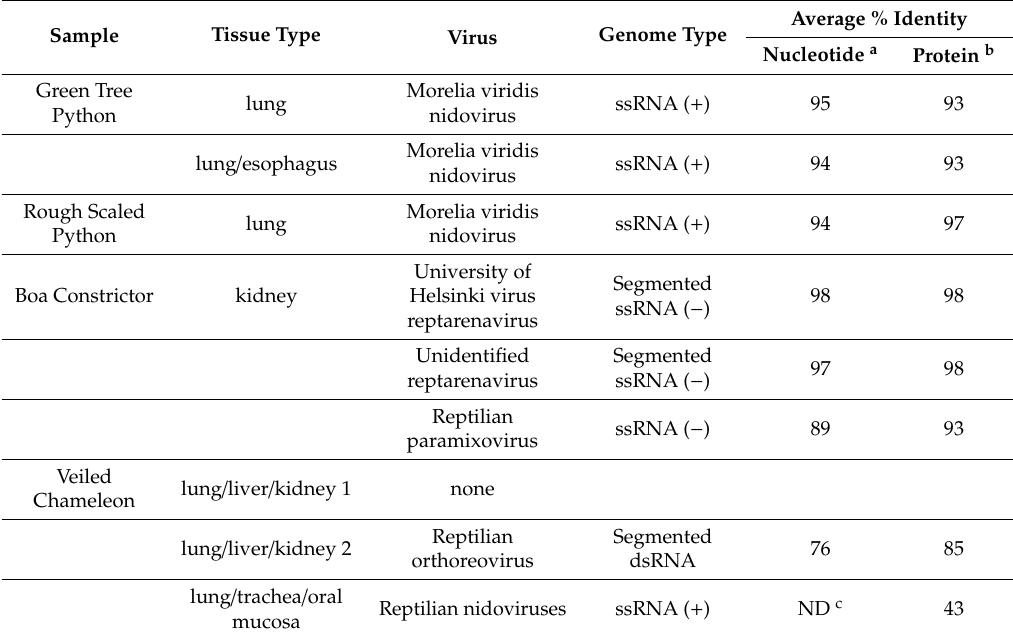
Figure 4. Classification of dsRNA contigs assembled from dsRNA isolated from reptiles and mule deer. Classification of dsRNA contigs from snake, mule deer, and chameleon samples according to BLASTn and BLASTx analysis. Viral contigs that potentially infect the samples; host and mitochondria, contigs with hits to host nuclear or mitochondrial genomes, respectively; bacteria / phage, contigs with hits to bacterial or bacteriophage sequences; other species, contigs with hits to non-host eukaryotic organisms or viruses known to infect non-reptilian species; unknown, contigs without hits to known sequences. More importantly, we were able to identify RNA viruses in the samples from the snakes and chameleon (Table 1). Table 1. Viruses identified in reptile